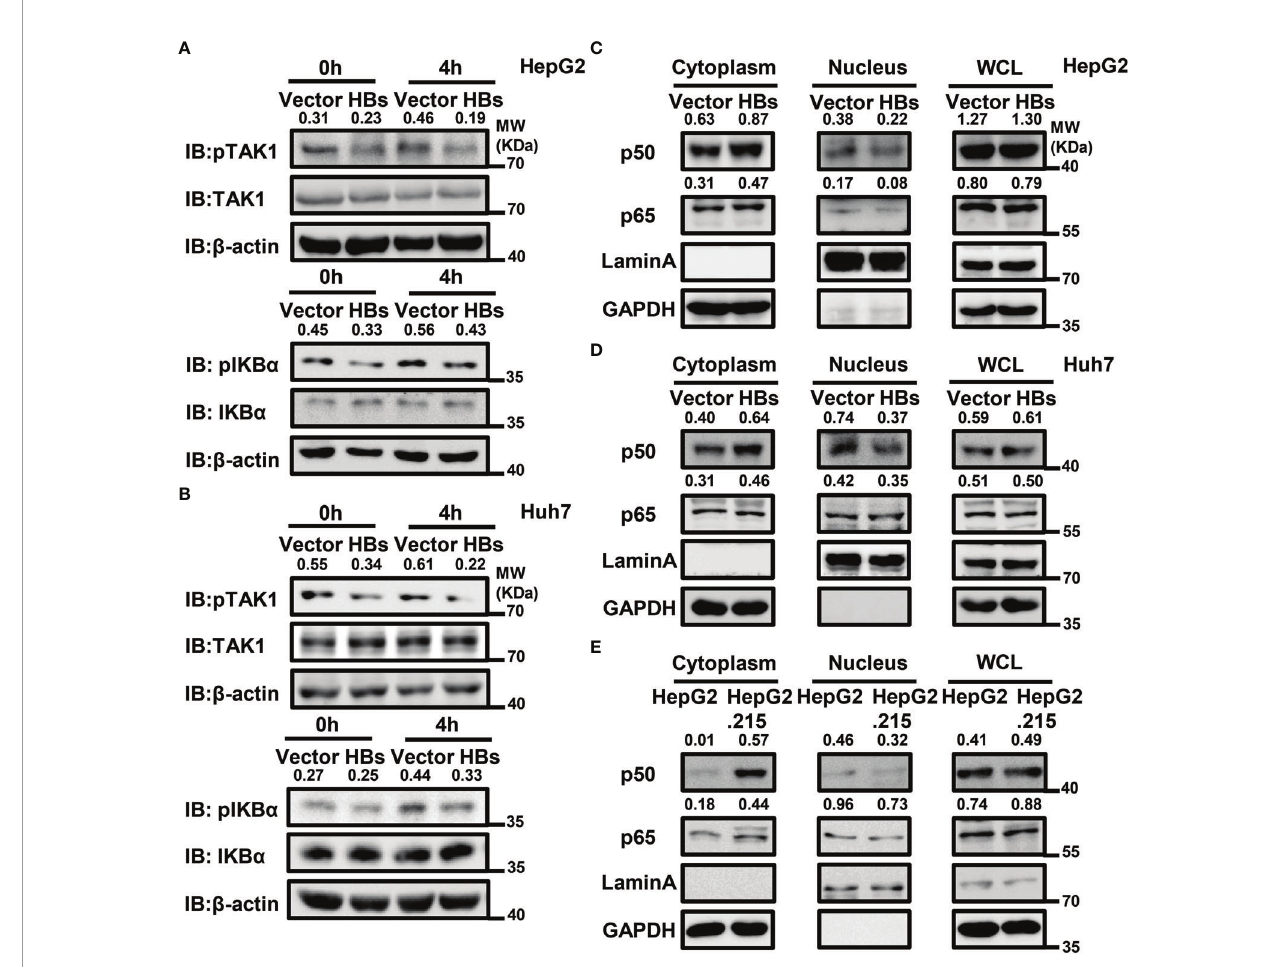
FIGURE 4 | HBsAg inhibits virus-triggered nuclear factor kappa B (NF-kB) activation. (A, B) HBsAg suppresses the phosphorylation of TAK1 and IKB a in HepG2 and Huh7 cells. HepG2 (A) or Huh7 (B) cells were transfected with vector plasmid or the HBs (3×Flag-HBsAg) expression plasmid for 24 h, then infected with SeV (MOI = 1) for indicated times, then harvested and immunoblotted with the indicated antibodies. (C, D) HBsAg blocked NF- k B subunits translocation from cytoplasm into the nucleus in HepG2 and Huh7 cells. HepG2 (C) or Huh7 (D) cells were transfected with vector plasmid or the HBs (3×Flag-HBsAg) expression plasmid for 24 h; HepG2 and HepG2.215 (E) were plated on collagen-coated six-well plate for 24 h. Then, cells were infected with SeV (MO I= 1) for 12 h. The whole cell lysates, the cytosolic and nuclear extracts were prepared as indicated in materials and methods, followed by western blot with indicated antibodies. GAPDH and LaminA were used as cytosolic and nuclear markers respectively. We use the Image J for the protein abundance analyses. All experiments were repeated three times with consistent results, and we showed the most representative